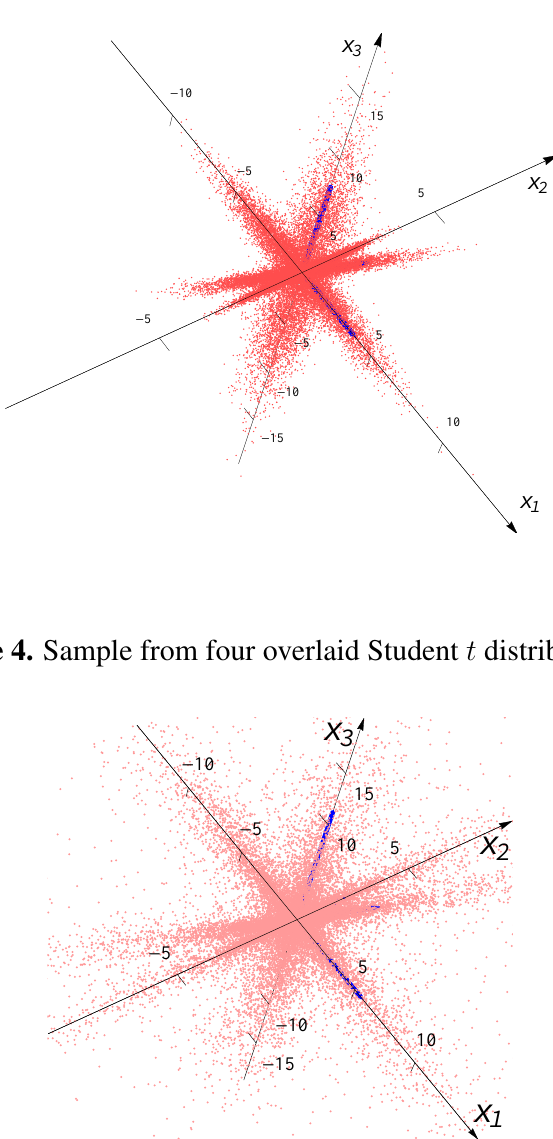
Figure 3. Sample from four overlaid Gaussian distributions.